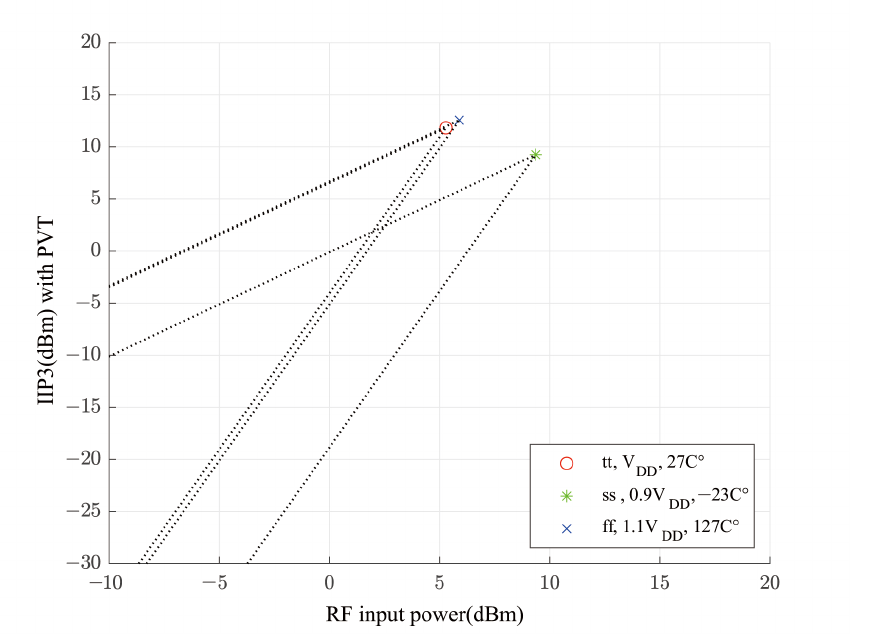
Figure 11. Third-order intercept point with PVT vs. V ov